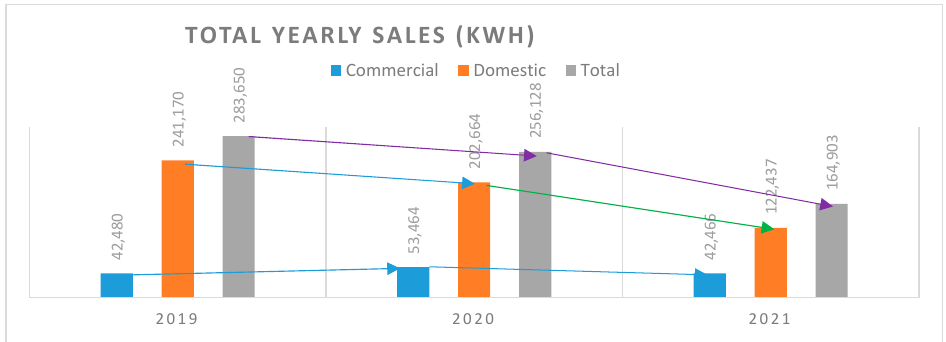
Figure 6. Total yearly sales showing declines in energy sales.